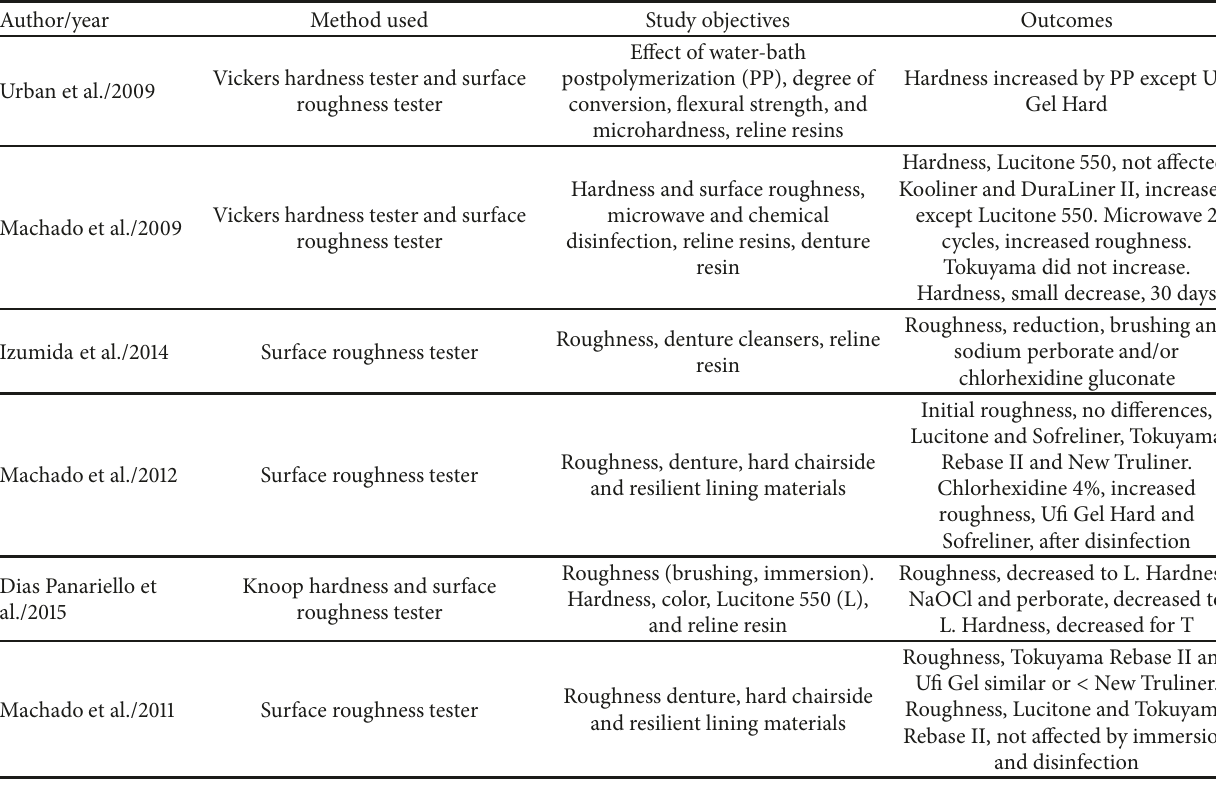
Table 3: Included studies related to the hardness and roughness for hard denture liners.